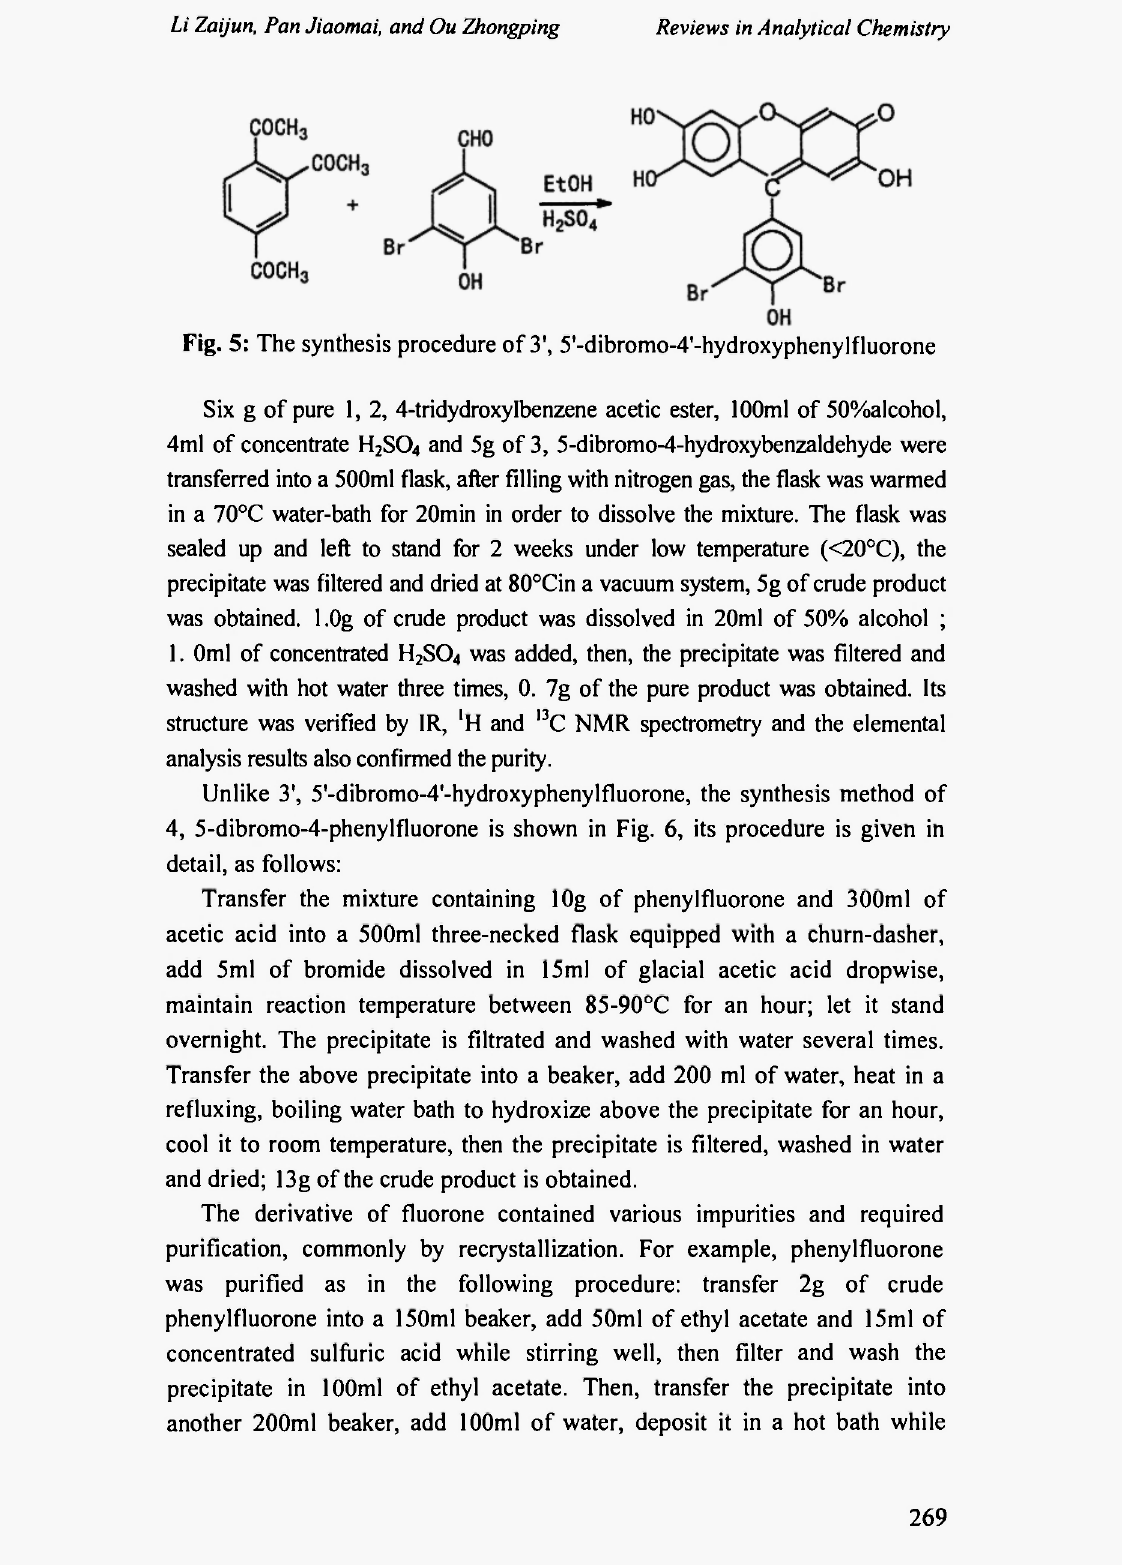
Fig. 5: The synthesis procedure of 3', 5'-dibromo-4'-hydroxyphenylfluorone Six g of pure 1, 2, 4-tridydroxyIbenzene acetic ester, 100ml of